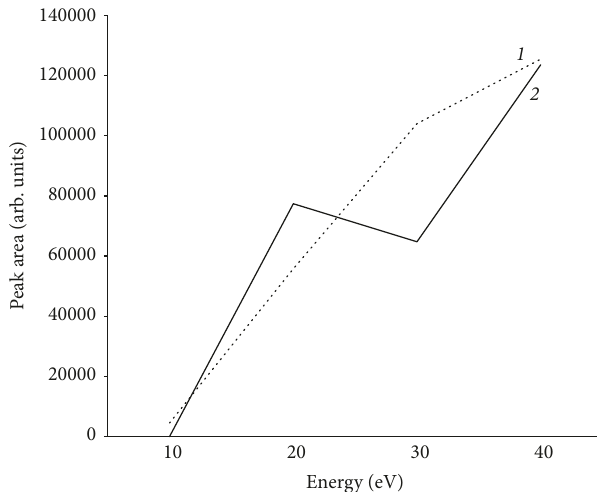
Figure 1: CID fragmentation of PBA (m/z = 169.06589). Variation of the fragment ion response (peak area) with the applied energy